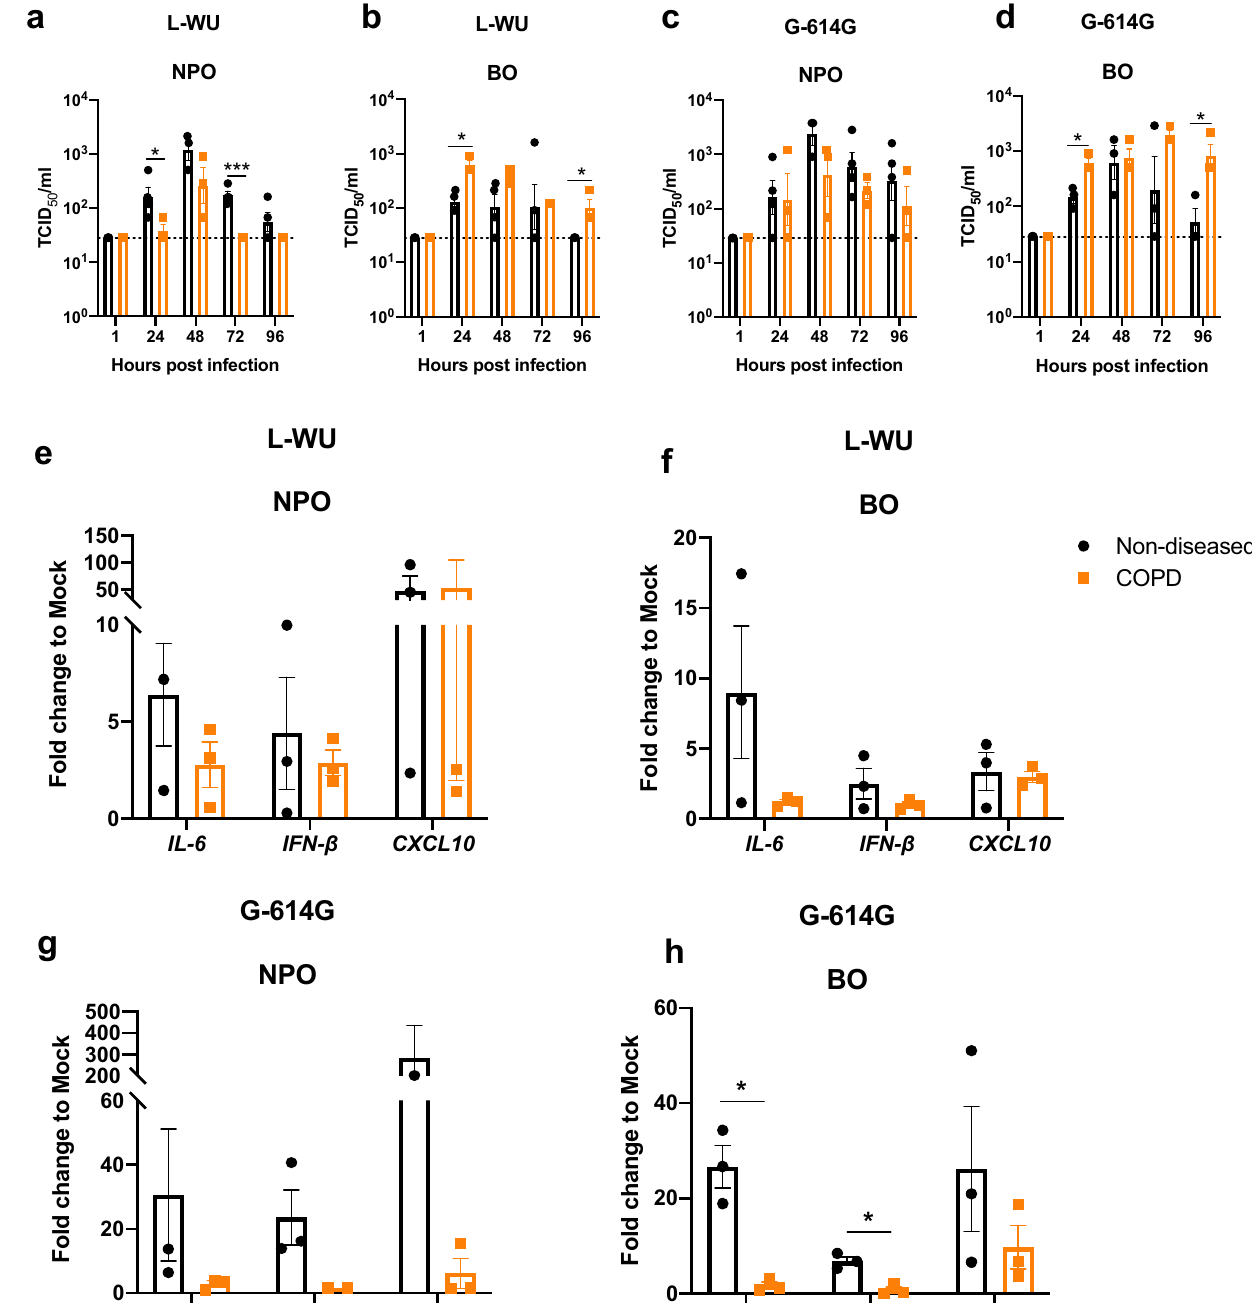
Fig. 5 | SARS-CoV-2 infection exhibits higher replicative competence in COPD bronchial organoids. a – d Viral replication kinetics from L-WU-infected and G-614G infected NPOs and BOs at 1, 24, 48, 72 and 96 hpi by TCID 50 assay. n =3 biologically independent experiments for NPO and BO infections are illustrated. Data are presented as means±SEM and unpaired t-test is performed. * P <0.05; *** P <0.001. [NPO L-WU: 24 hpi=0.0494; 72 hpi=0.0004; BO L-WU: 24 hpi=0.0110; 96 hpi=0.0152; BO G-614G: 24 hpi=0.0294; 96 hpi=0.0457]. e – h qRT-PCR analysis